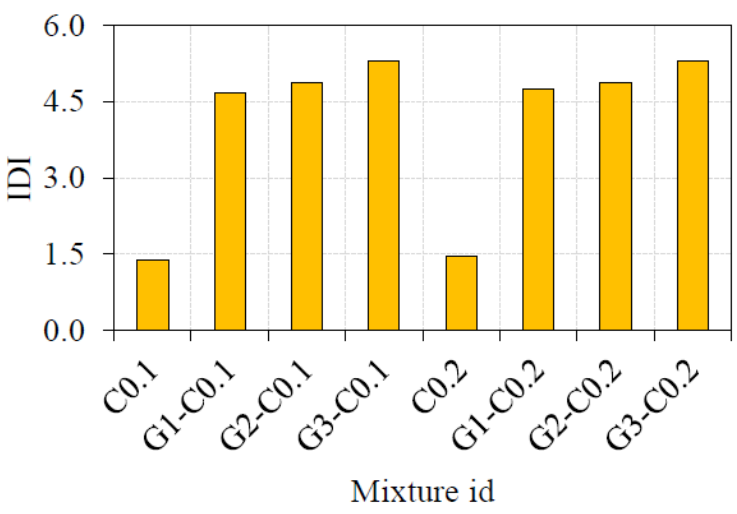
Figure 7. Ductility index of composite .